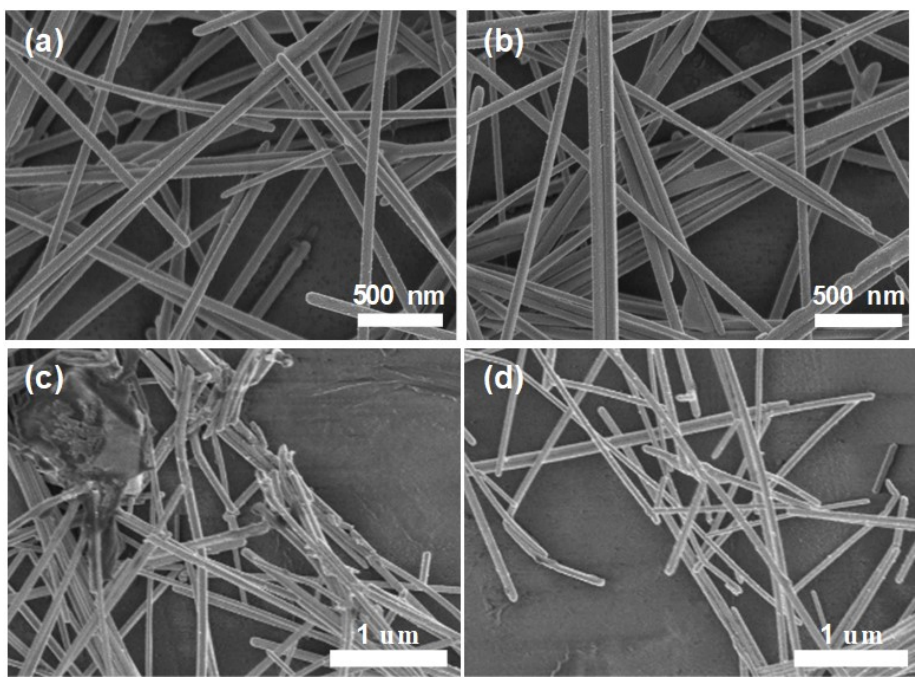
Figure 2. Plan view SEM images taken for Ag nanowire electrodes on ( a ) PI and ( b ) PET substrates before bending and on ( c ) PI and ( d ) PET substrates after 400,000 cycles of bending.